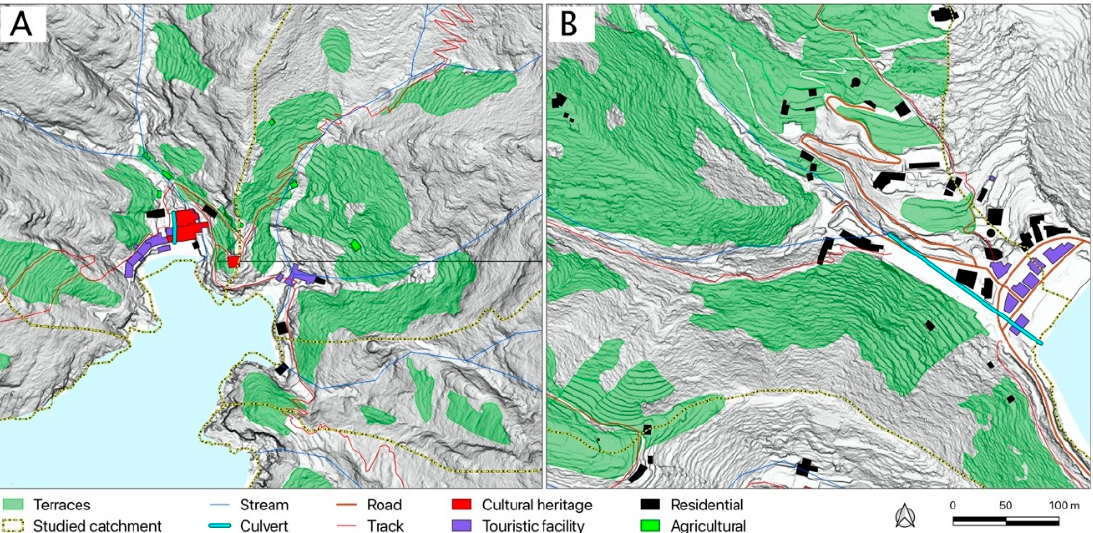
Figure 12. The spatial relationships between terraced areas and cultural heritage, buildings and roads at the mouth of the main studied catchments: ( A ) in San Fruttuoso and ( B ) Paraggi catchments (see orange boxes in Figure 1).